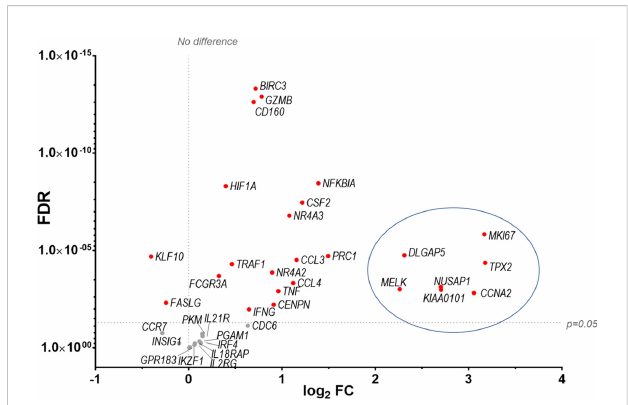
FIGURE 11 Identi fi cation of a transcriptomic signature common to human NK cells post vaccination with MVA and murine NK cells post infection with VACV strain WR. Groups of B6 mice ( n =4) were mock-infected or infected with VACV WR. At 6.5 d.p.i., NK cell mRNA abundance was studied by RNA-seq and differential expression of transcripts was calculated (WT vs mock). The transcriptomic data (qPCR) from a study looking at human NK cells (n=11) before and at 7 d post MVA vaccination (10 data reference GSE110446) was compared to our RNA- seq data. Transcripts whose expression post vaccination with MVA was differentially expressed with a FC > ± 1.5 were selected. The expression of such transcripts was analysed in our RNA-seq data. All such transcripts in our dataset were described as upregulated in (10). Their differential expression in our dataset is represented on the graph. Each dot represents a transcript, the FC (VACV vs mock) is expressed on the X-axis as log2, and the FDR is shown on the Y axis. Red indicates statistical signi fi cance (FDR<0.05). Circled are the transcripts that were most signi fi cantly (FDR<0.05) upregulated at 7 d.p.i. with